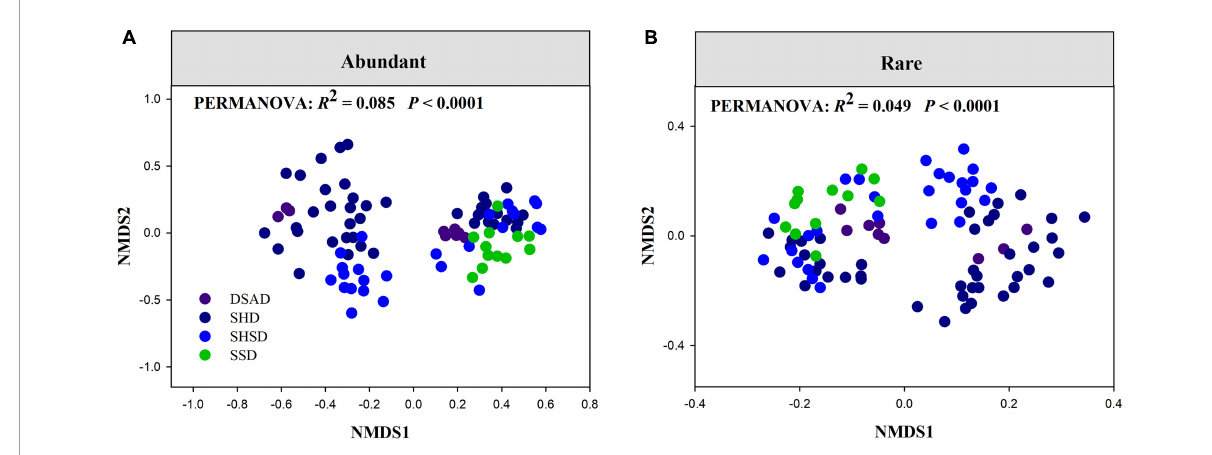
FIGURE3 Non-metric multidimensional scaling (NMDS) ordination of the community composition of (A) abundant and (B) rare fungi across four vegetation types. DSAD, Dwarf Semi-arboreous Desert; HSPD, Shrubby Steppe Desert; SHD, Shrubby Desert; SHSD, Semi-shrubby and dwarf semi-shrubby desert.